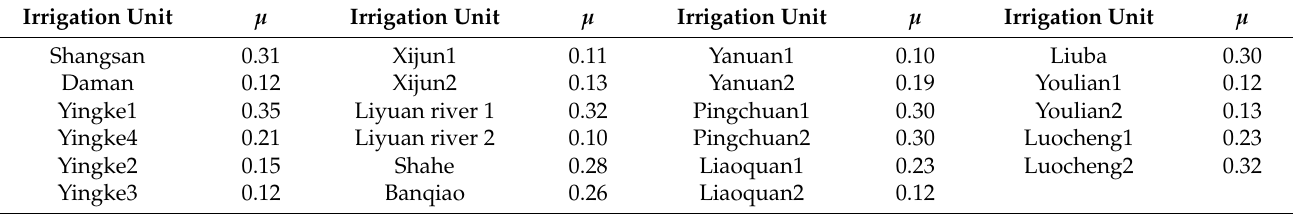
Table 2. Optimal value of degree of unit water supply in the middle irrigation area.